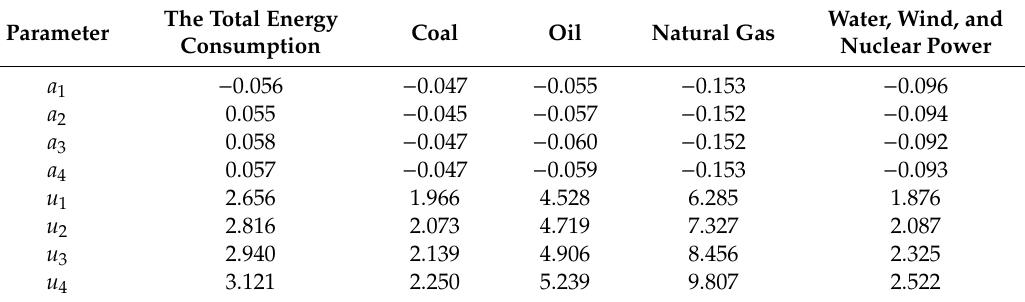
Figure 3. The procedure of RGM-SVR. Table 5. Parameter estimation of RGM.